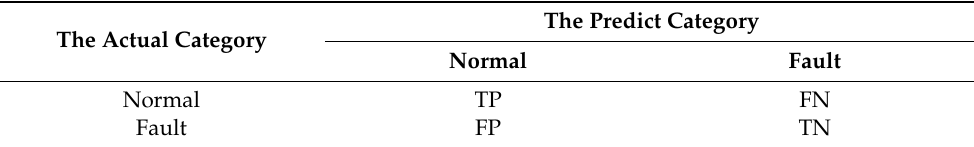
Table 2. Confusion matrix of dichotomies problem.